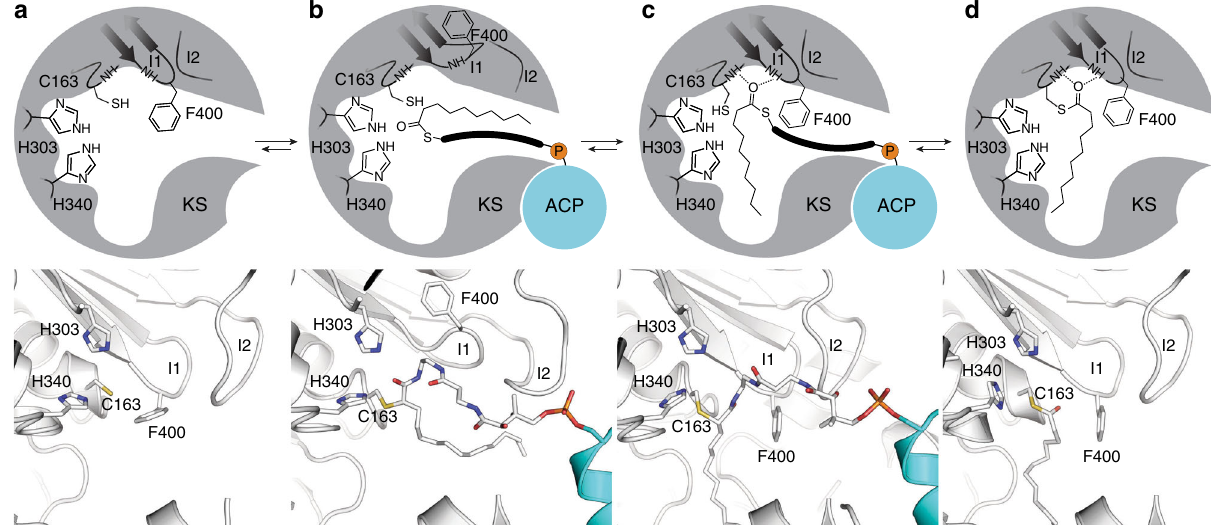
Fig. 10 Proposed gating mechanism of elongating ketosynthases. Figure demonstrates the active site conformational changes that facilitate acyl-chain transfer in elongating KSs as demonstrated by trapped crystallographic states from this work and previous studies. a The apo- form of the KS active site illustrated by a 2D schematic of the active site architecture (top) and the crystal structure of apo-FabF (PDB: 2GFW) (bottom). b Active site reorganization to the gate-open conformation upon association of acyl-AcpP with KSs as seen in the C16AcpP – FabF structure reported herein with a 2D schematic of the active site (top) and 3D rendering of the active site (bottom). c Active site of C12AcpP – FabB, illustrating the gate-closed transacylation competent form of the active sites of elongating KSs shown as 2D schematic (top) and 3D rendering (bottom). Residues are represented in FabF numbering. d The acyl- enzyme adduct form of FabF (PDB: 2GFY) shown as a 2D schematic (top) and 3D rendering (bottom). Active site catalytic residues Cys163, His303, His340, and Phe400 are provided in FabF residue numbering, represented as sticks, and colored according to element (C-white, O-red, N-blue, S-yellow). Hydrogen-bonding interactions are represented as dotted